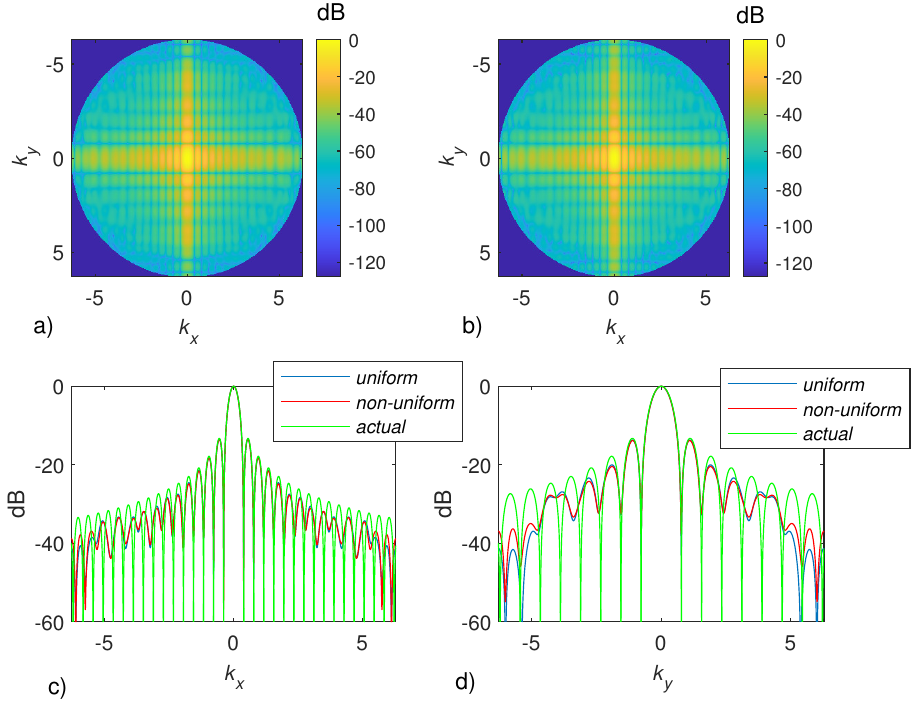
Figure 6. Normalized amplitude of the radiation pattern of J 2 ( x , y ) with X s = 8 λ , Y s = 4 λ , z o = 7 λ , X 0 = 10 λ and Y 0 = 6 λ . In ( a ), the radiation pattern is obtained by employing the near-field data according to the proposed non-uniform sampling scheme over the grid shown in panel ( a ) of Figure 2 and then interpolated over a λ /2 grid. In ( b ), the radiation pattern is obtained by directly employing the near-field data over a uniform λ /2 grid. Panels ( c , d ) have been obtained by fixing k y = 0 and k x = 0, respectively, and compare the radiation pattern cut-views passing through the main-beam maximum. The green lines refer to the actual radiation pattern, the blue lines to the radiation pattern computed by using the uniform λ /2 sampling and the red ones show the radiation pattern obtained by the proposed method. Noiseless